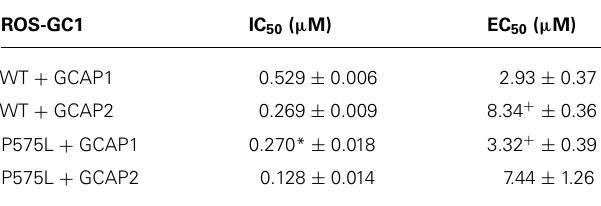
*Six data sets; + two data sets. Values are the mean ± SD of mainly three to four independent measurements, if not indicated